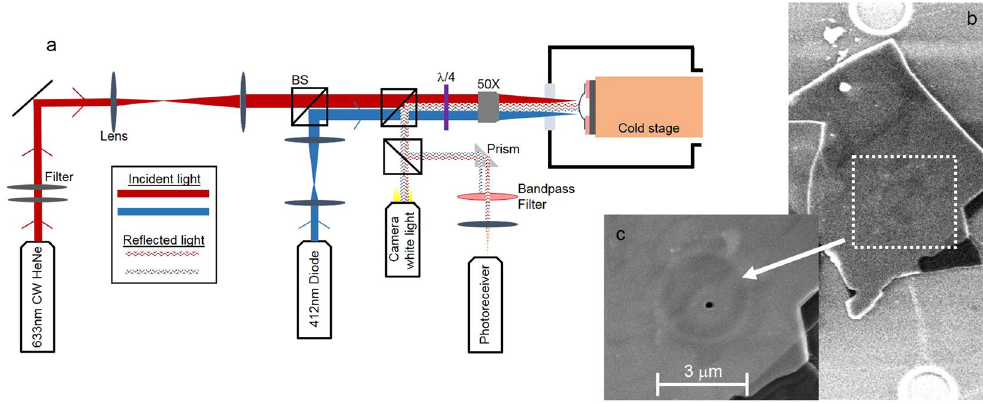
Figure 1. Optical interferometer and MoS 2 resonator. ( a ) Schematic showing the optical interferometer, and sample mount within the variable temperature cryostat. BS = Beam Splitter. λ /4 = quarter-wave plate. ( b and c ) Scanning electron microscopy images of one of the MoS 2 resonators tested within this study. The observable hole near the center of the resonator in ( c ) was made by ion milling with a focused ion beam to test the impact of trapped air beneath the MoS 2 on the overall mechanical properties of the resonator.